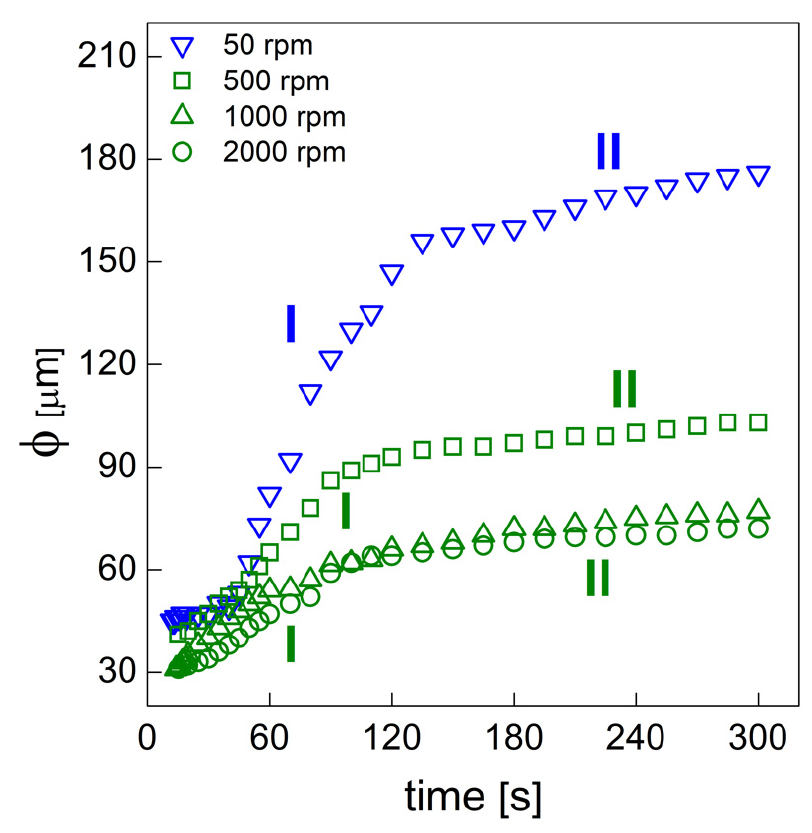
Figure 6. Bubble size evolution of the PU foams obtained at different mixing speeds.